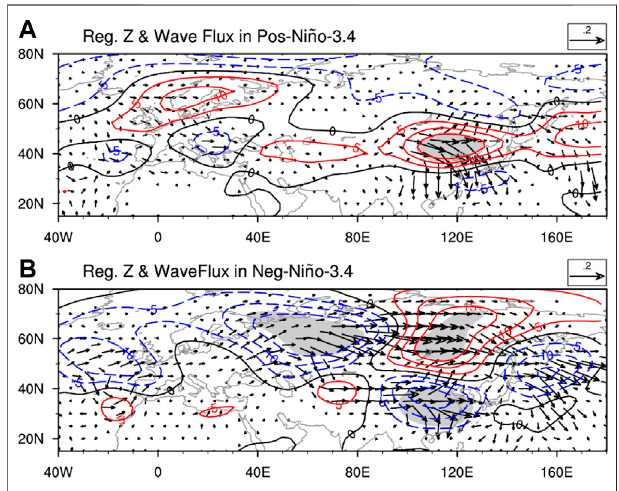
FIGURE 5 | Regression of summer 200-hPa geopotential height (contour,m) and waveactivity fl ux (arrows, m) ontosummerHK Precforyears with (A) a positive Niño-3.4 index and (B) a negative Niño-3.4 index. Shading indicates the 90% con fi dence